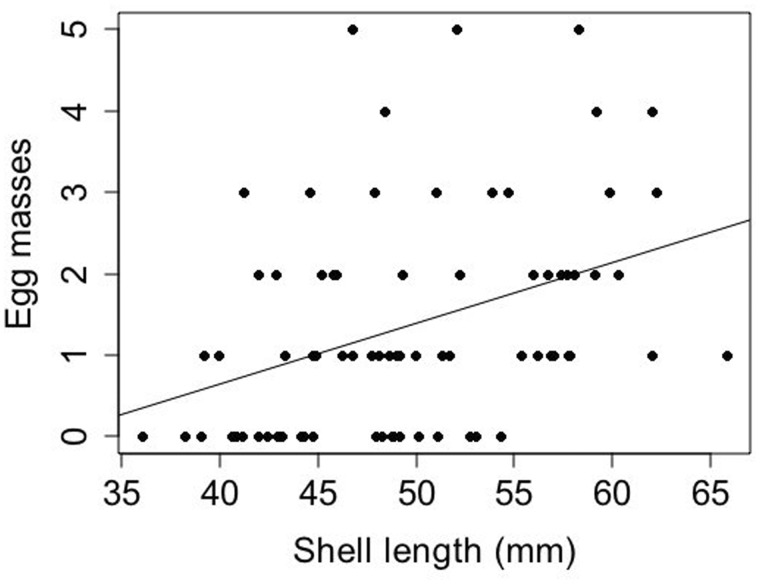
Total egg mass production over four reproductive cycles plotted against shell length of paired and solitary S. gigas. There was a significant, but weak positive association between length and the number of egg masses produced (GLM, z = 3.10, P = 0.0019). Points are jittered for clarity.